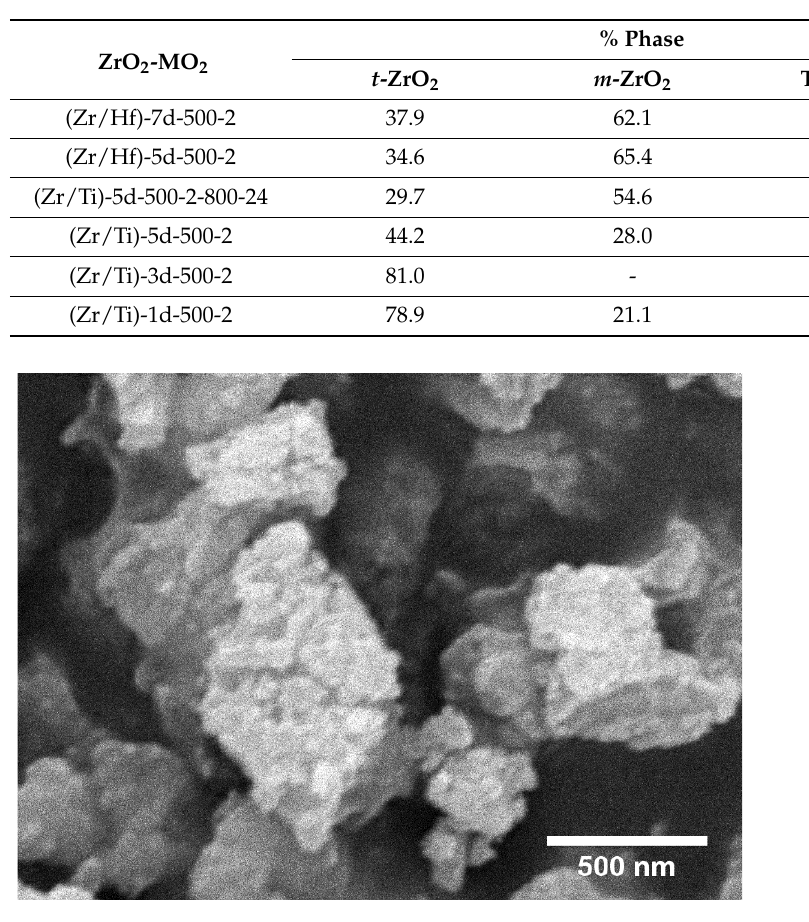
Figure 4. SEM image of ZrO 2 -TiO 2 composite for (Zr/Ti)-5d-500-2.